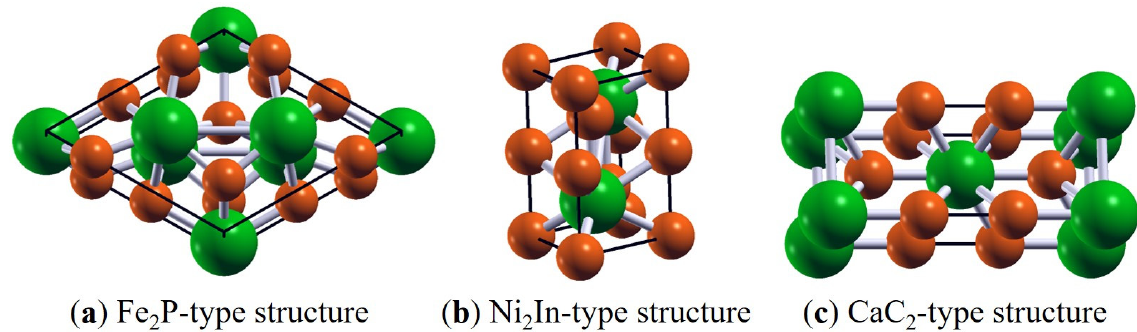
Figure 1. Crystal structures of TiO 2 phases (generated using XCrySDen software [45]). The green spheres represent the titanium atom, while the alloy orange spheres represent the oxygen atom. ( a ) Fe 2 P ‐ type: crystal structure: hexagonal, space group: 𝑃 6 (cid:3364) 2 𝑚 , coordination number: 9, lattice param ‐